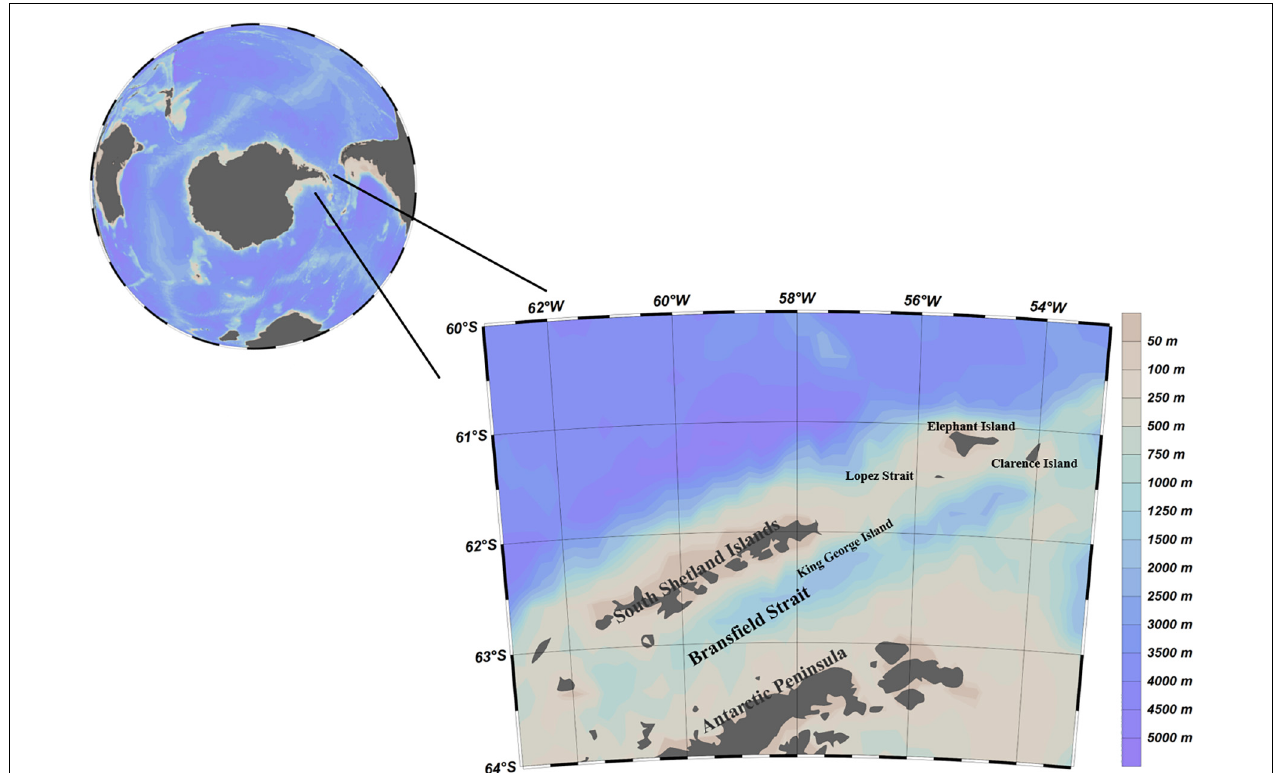
FIGURE 1 | Research